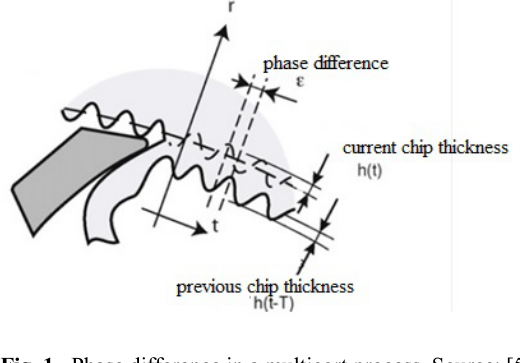
Fig. 1. Phase difference in a multicort process. Source: [5]